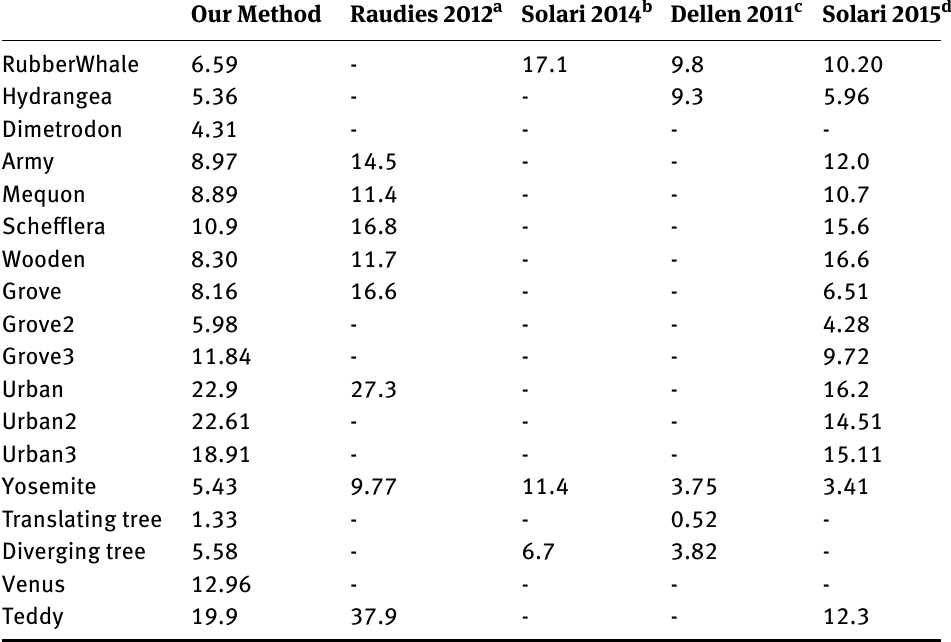
Table 3: Comparisons of the average angular errors of our model and some state-of-the-art bio-inspired works in the literature. Our